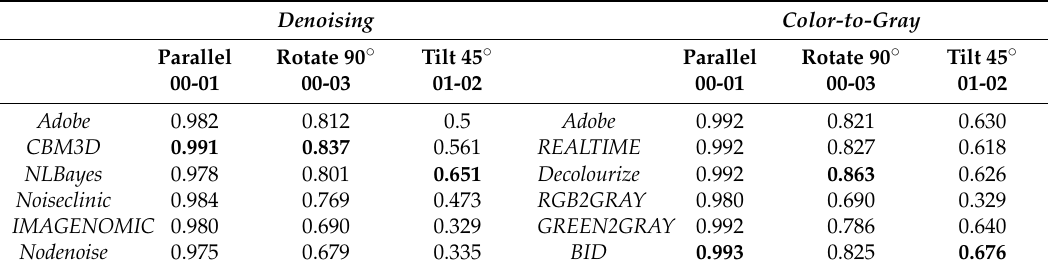
Table 1. Efficiency of each denoise and color-to-gray technique for the image pairs of Dataset 1. Adobe method is Camera Raw 6 with Process 2010 (see Section 3.1).